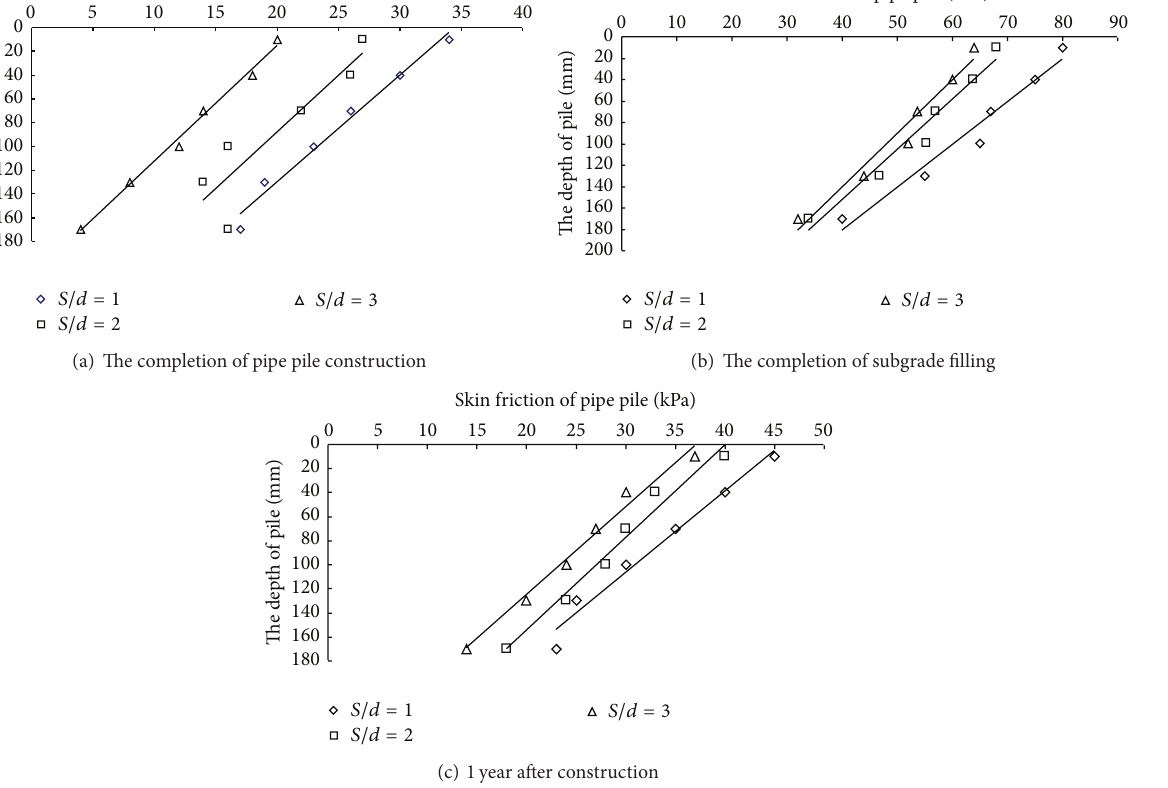
Figure 10: Skin friction distributions along the pile